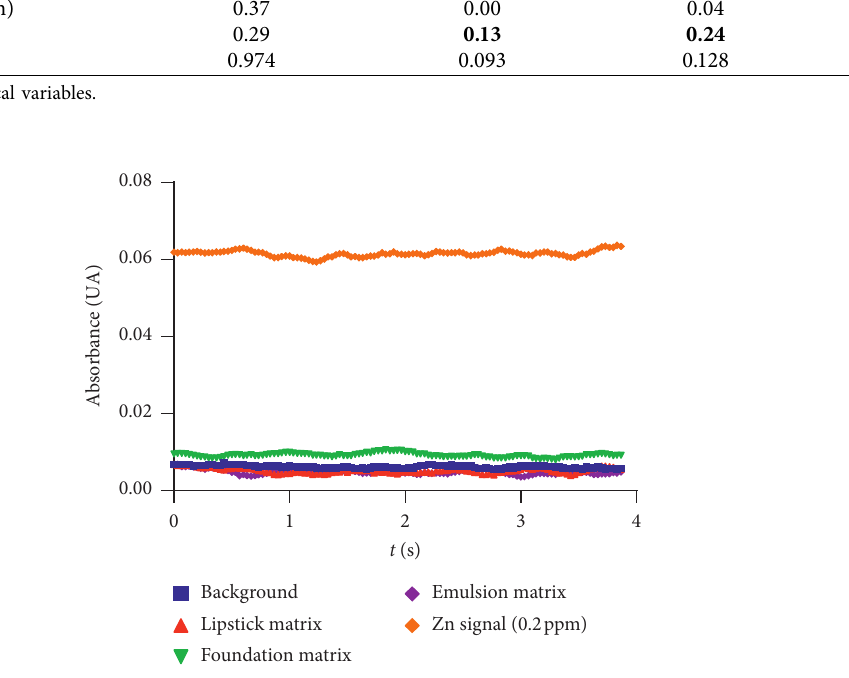
Figure 1: Absorbance as a function of time for background, placebo blanks, and Zn (0.2ppm)